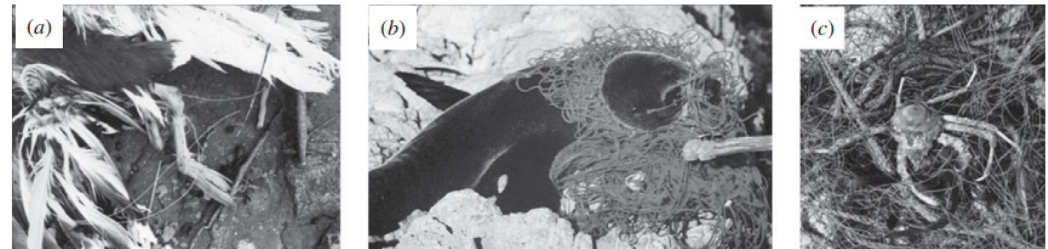
Figure 3. Examples of animals that ingested microplastics: ( a ) southern black-backed gull, Larus dominicanus caught and hooked in nylon filament fishing line; ( b ) a New Zealand fur seal trapped in discarded netting and ( c ) Ghost fishing-derelict fishing gear dredged from > 100 m on the Otago shelf (taken from reference [23] with permission of the Royal Society).